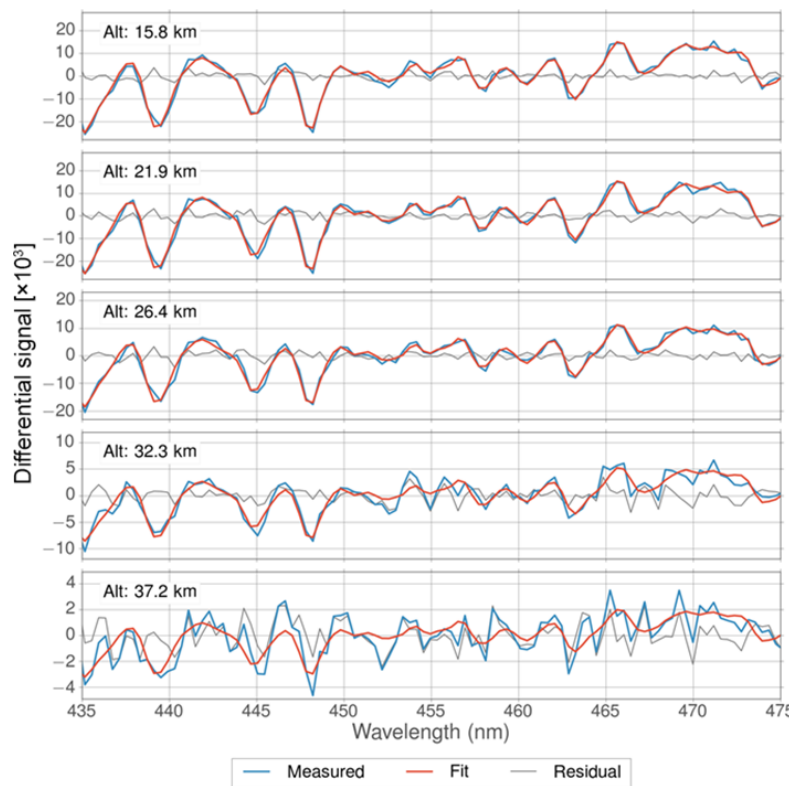
Figure 1. Measured and fitted differential optical depth (DOD) as a function of tangent height (“Alt”) in the spectral window used for NO 2 retrieval. The residual is calculated as measured DOD minus fitted